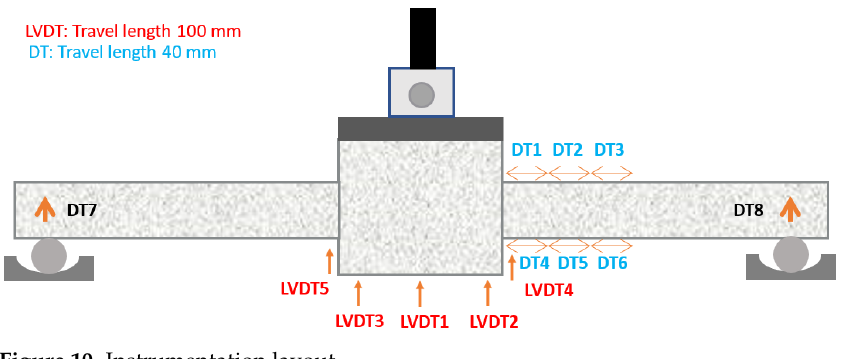
Figure 10. Instrumentation